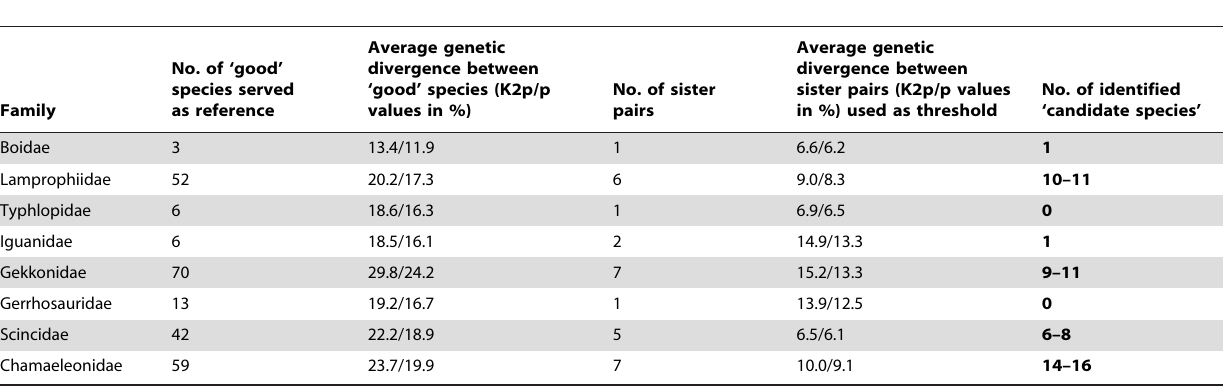
Table 2. Data on genetic divergences in various Madagascan reptile lineages, and approximate number of candidate species found in our data set (see details in text).